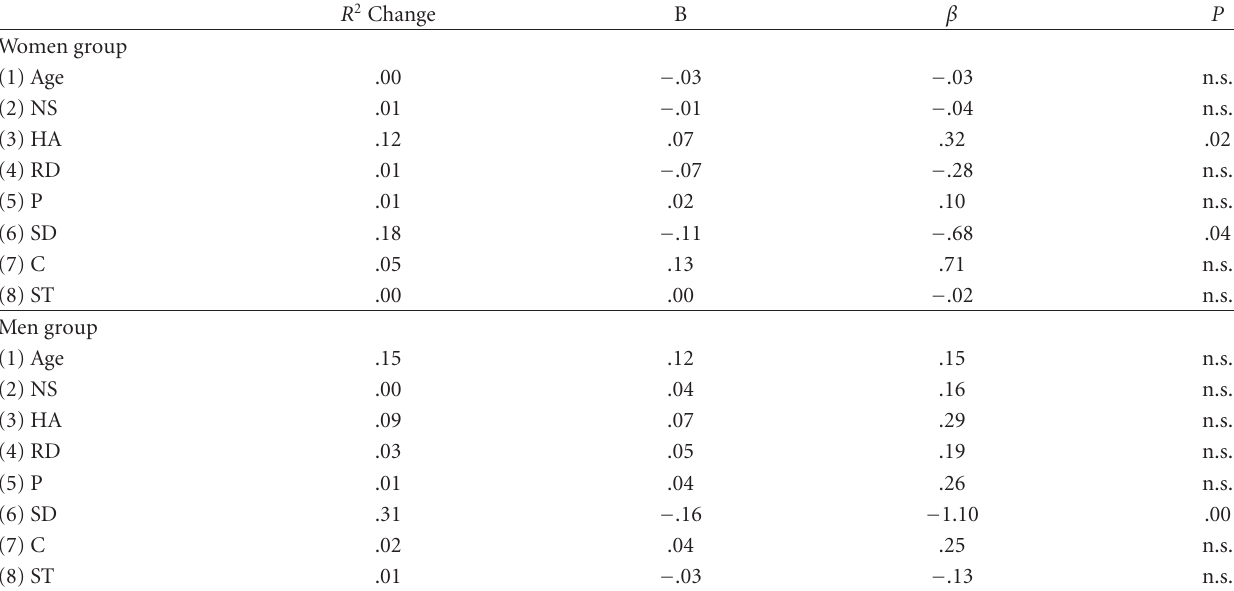
Table 3: Percentage of variance, significance, B and β indexes, in Beck score explained by the di ff erent predictors (TCI temperament and character scales) in the Hierarchical Multiple Regression Equations (women and men